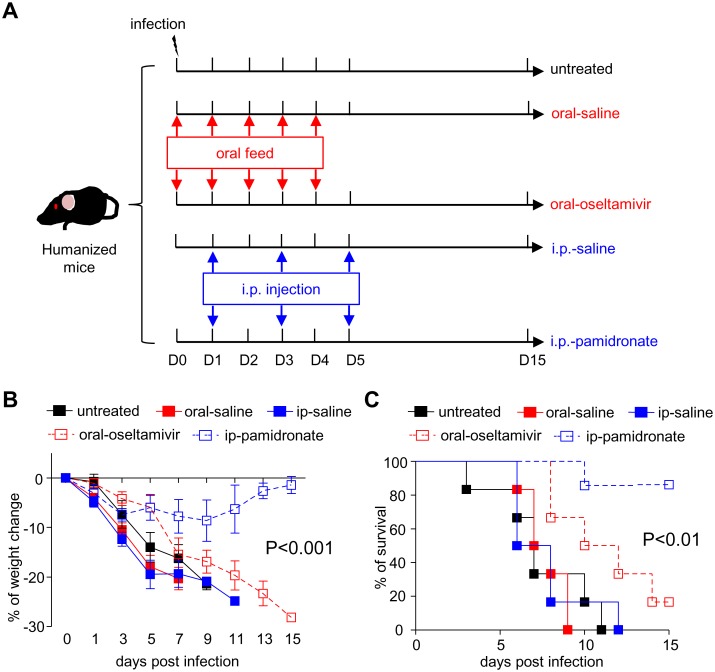
Effects of oseltamivir and pamidronate on lethal H7N9 infection in humanized mice.A. Protocol of assessing effects of oseltamivir and pamidronate on lethal H7N9 infection in humanized mice. Humanized mice established from PBMCs of same donors were infected with H7N9 virus i.n.at 106 TCID50 in 25μl of saline solution on day 0 and distributed to corresponding groups. Pamidronate (i.p.-pamidronate group) or saline of equivalent volume (i.p.-saline group) was injected i.p. on day 1 (10mg/kg), 3 and 5 (5mg/kg per dose) post infection whereas 50mg/kg oseltamivir (oral-oseltamivir group) or saline of equivalent volume (oral-saline group) was given by oral gavage twice a day for 5 consecutive days since day 0 post infection. The weight change (B) and survival (C) of virus-infected mice (6 mice per group) were monitored and recorded till day 15 post infection. The data are representative of three independent experiments.